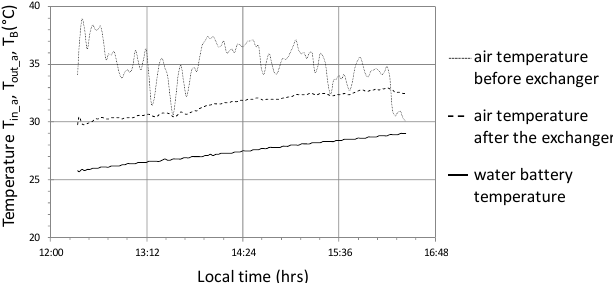
Figure 21. Timescale of temperature distribution in the heat storage system in the water accumulator for cycle No. 2.